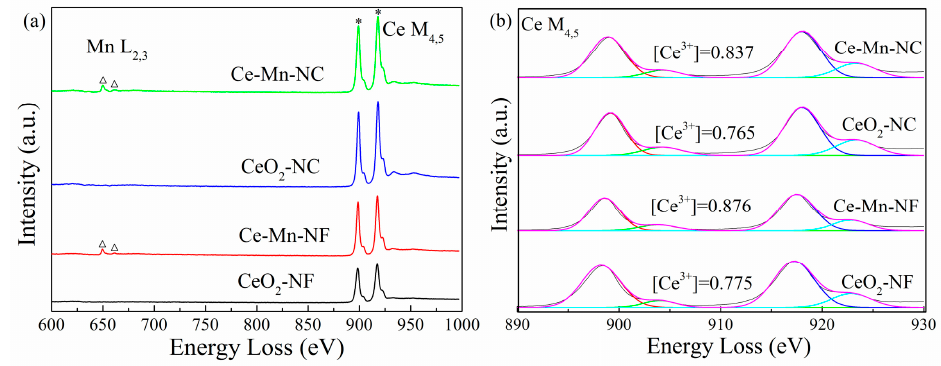
Figure 5. Ce M 4,5 -edge, Mn L 2,3 -edge EELS spectra ( a ) and Ce 3+ distribution of CeO 2 samples ( b ). EPR is a sensitive to the paramagnetic species with unpaired electrons [40]. Thus, EPR spectra of the pure CeO 2 and Mn-doped CeO 2 samples were collected to study the oxygen vacancies and the species of reactive oxygen ( · O 2 − , 1 O 2 and · OH) [41,42]. As presented Figure 6a, pure-CeO 2 (CeO 2 -NF and CeO 2 -NC) exhibited two types of peaks of Ce 3+ in terms of the surface (g = 1.965) and bulk (g = 1.947). After Mn doping, Mn- doped CeO 2 presented a strong EPR signal at g = 2.032, ascribed to the combination of Mn ion with one or two electrons [43,44]. The typical · O 2- quartet spectrum, 1 O 2 triplet spectrum and · OH spectrum can be detected for all the catalysts (Figure 6b–d). The intensities of peaks corresponding to · O 2 − and 1 O 2 respectively in the Mn-doped CeO 2 catalyst are far higher than those of CeO 2 . This may be due to more Ce 3+ to Ce 4+ transition on the catalyst surface of Mn-doped CeO 2 , which provided many electrons to O 2 and accelerated the conversion O 2 to active oxygen species. It is beneficial to accelerate the catalytic oxidation of benzene. It is worthy to note that CeO 2 only exhibit · OH characteristic quartet peaks, however Mn-doped CeO 2 contain other peaks attributed to oxidized DMPO (radical scavenger) besides · OH peaks, which indicate that Mn-doped CeO 2 possess higher oxidization ability (Figure 6d). Therefore, it is easier to catalytic oxidize benzene for Mn- doped CeO 2 . The EPR patterns of oxidized DMPO, labeled as DMPO-X can be seen in the Supplementary Materials.